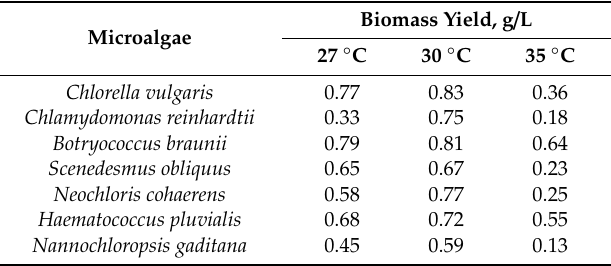
Table 1. The influence of temperature on the growth of various microalgae (table reconstructed using data from Varshney et al.